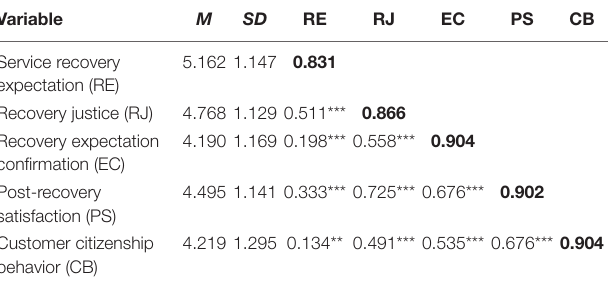
TABLE 3 | Correlations and square roots of AVE.